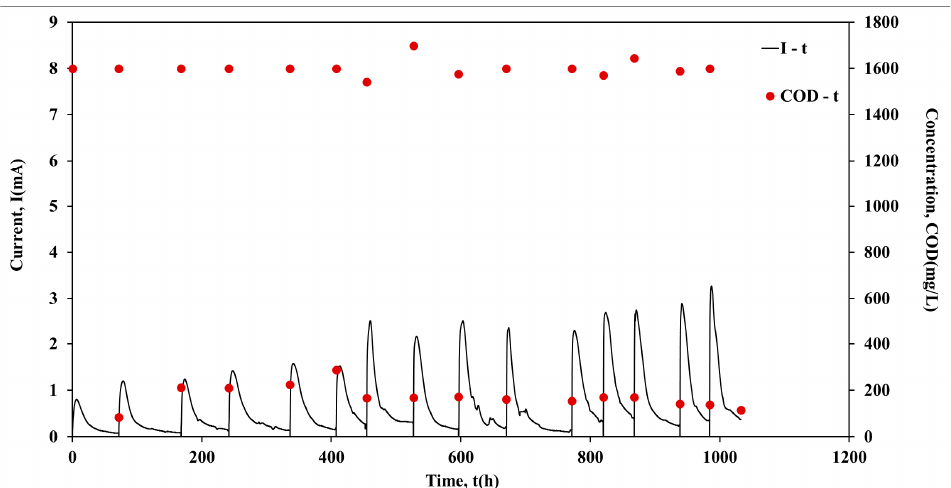
Molecules 2021 , 26 , 3987 Figure 3. Current output (mA) and COD concentration (mg/L) versus time of Cell 3, during batch operation.